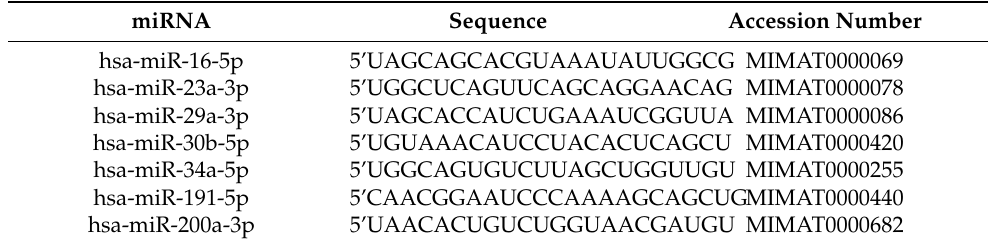
Table 1. Selected miRNAs, sequences, and their accession numbers by Qiagen, Hilden,